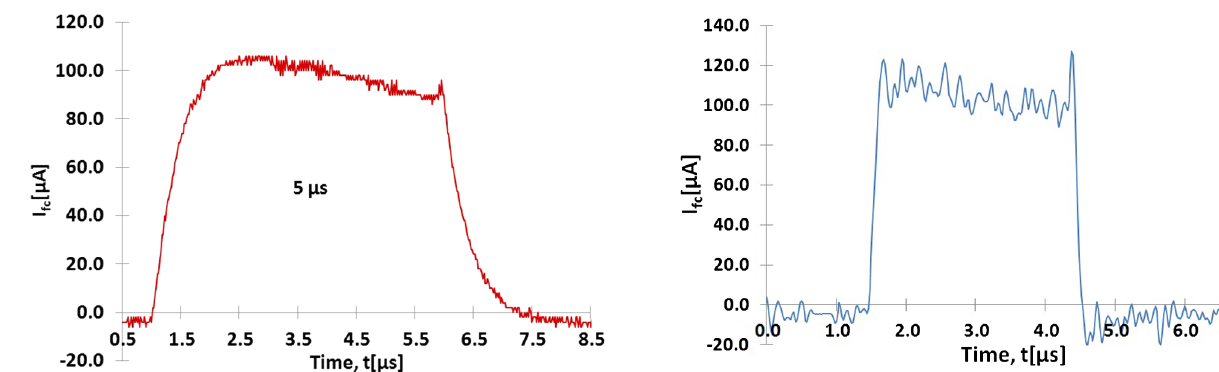
FIG. 15. Chopped beam pulse with a duration of 5 (cid:1) s . FIG. 17. Reconstructed beam profile with a duration of 3 (cid:1) s .